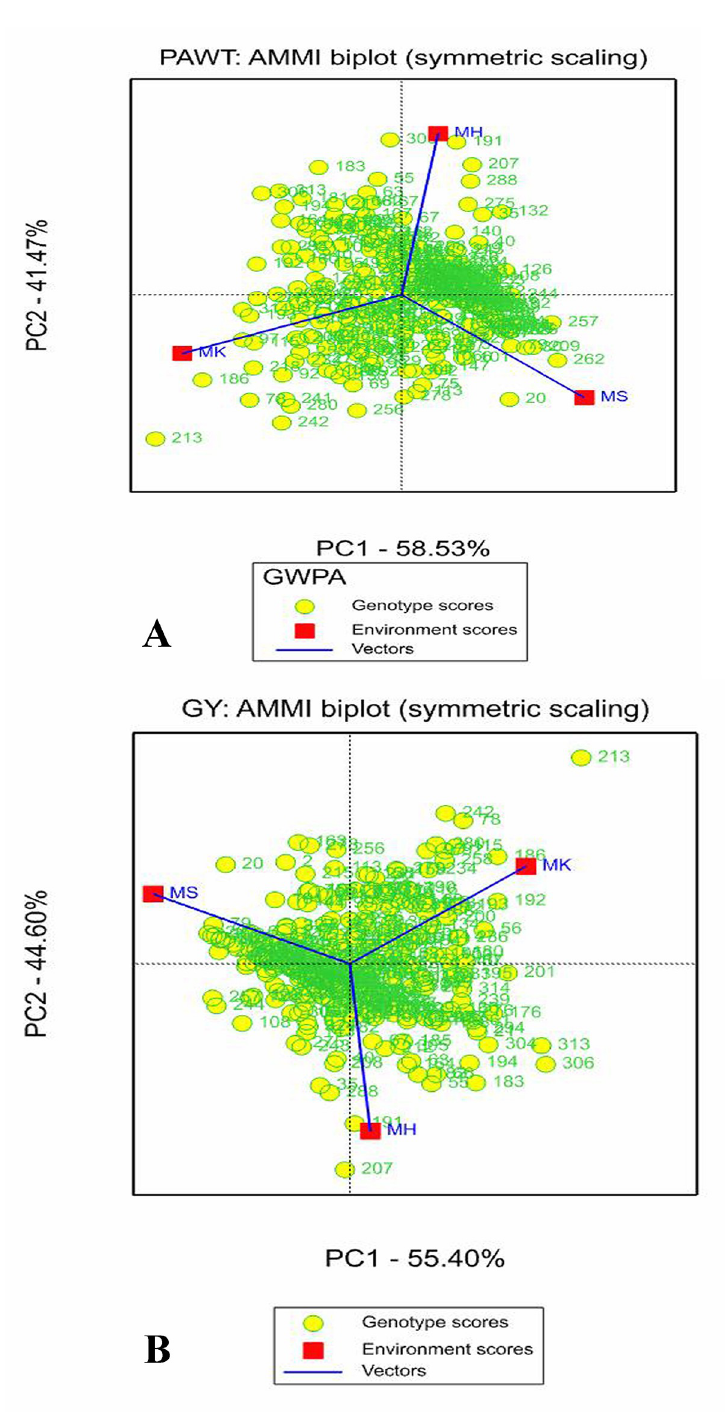
Fig 3. AMMI2 biplot of the 324 sorghum genotypes and three environments for (A) panicle weight (PAWT) and (B) grain yield (GY). Genotypes placed close to a given environment, had top performance in that environment. Each vector shows the discrimination power of the environment (the longer the vector the more discrimination power that environment has).